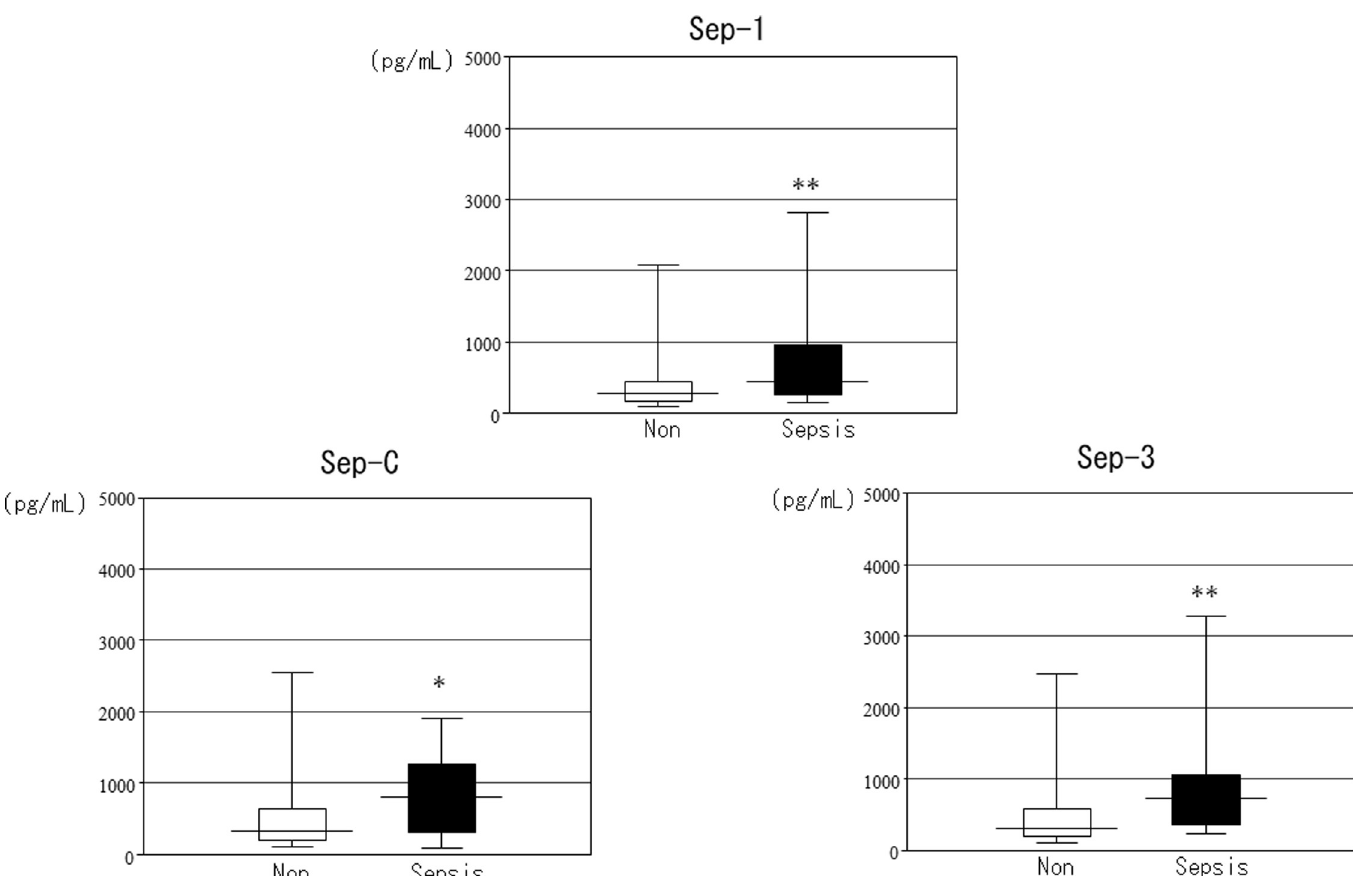
Fig 5. Comparison of Pre levels in patients with and without each sepsis diagnosis[patients with eGFR � 60 (N = 315)]. The horizontal bars represent the median, the boxes represent the IQR, and the vertical bars represent the upper and lower limits. Non: The group of non-septic patients. Sepsis: The group of septic patients. The median Pre (IQR) values are as follows: Sep-1: Sepsis (N = 144), 445 (262–957) vs. Non (N = 171), 274 (176–448) pg/mL; Sep-C: Sepsis (N = 17), 802 (311–1267) vs. Non (N = 298), 322 (206–640) pg/mL; Sep-3: Sepsis (N = 35), 732 (367–1062) vs. Non (N = 216), 299 (195–588) pg/mL. � p < 0.05, �� p < 0.01 by the Mann–Whitney U test vs.